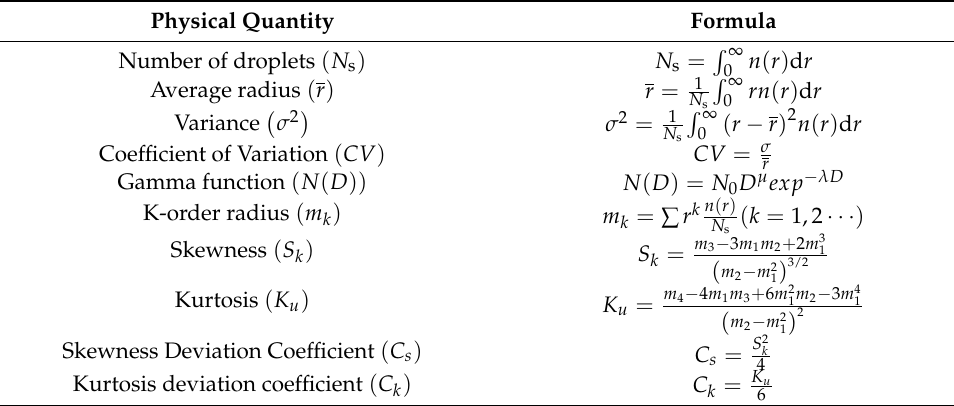
Table 2. Calculation formulas of physical quantities used in the subsequent